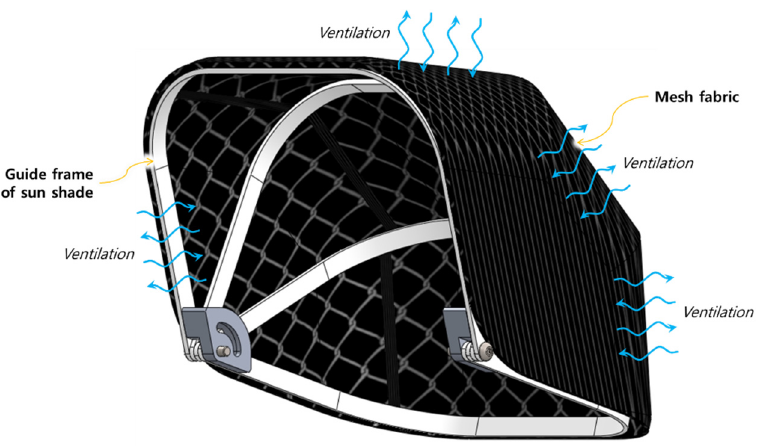
Figure 6. Sunshade for multi-modal sensor module.